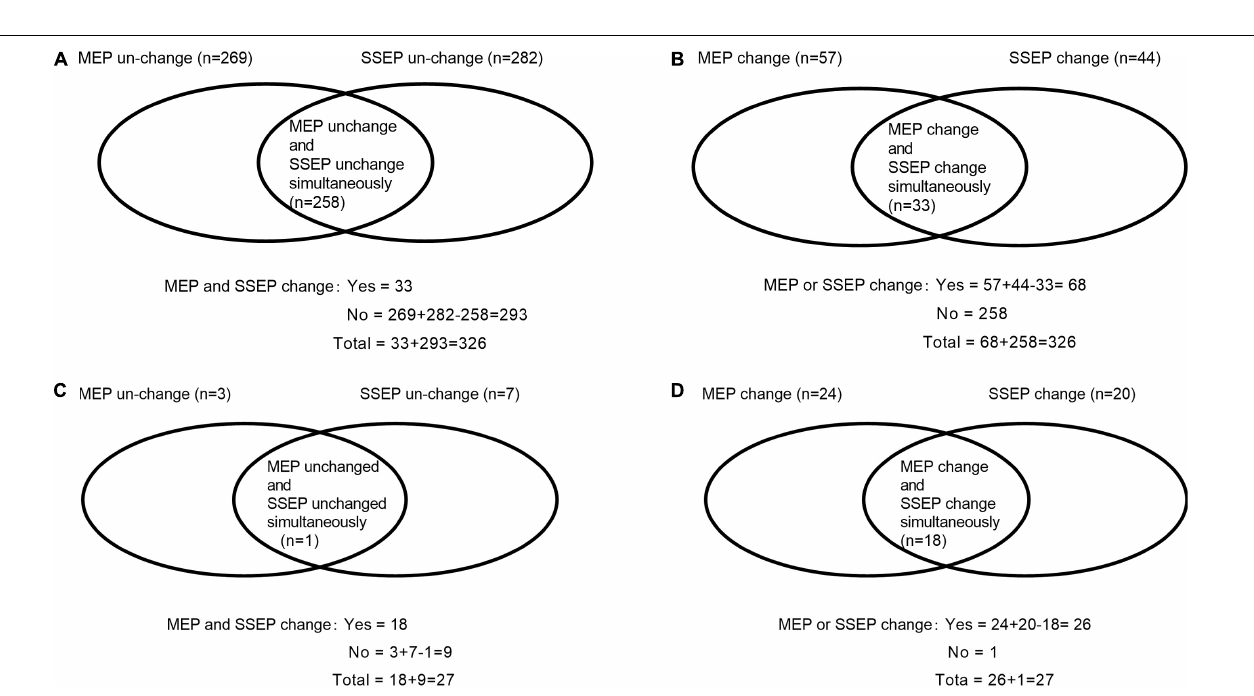
FIGURE 2 | Description of the numbers of cases under single- and/or multimodal intraoperative neuromonitoring by Venn diagram, as well as the numbers of patients who developed new PONDs after posterior decompression surgery for thoracic spinal stenosis (TSS) under single- and/or multimodal intraoperative neuromonitoring. The numbers of cases with SSEP change-, MEP change-, SSEP and MEP change-, as well as SSEP or MEP change- were 44, 57, 33, and 68, respectively (A,B) . Furthermore, the numbers of patients developed PONDs after TSS under the corresponding neuromonitoring were 20, 24, 18, and 26, respectively (C,D) . SSEP, somatosensory-evoked potential; MEP, motor-evoked potential; PONDs, postoperative neurological deficits.